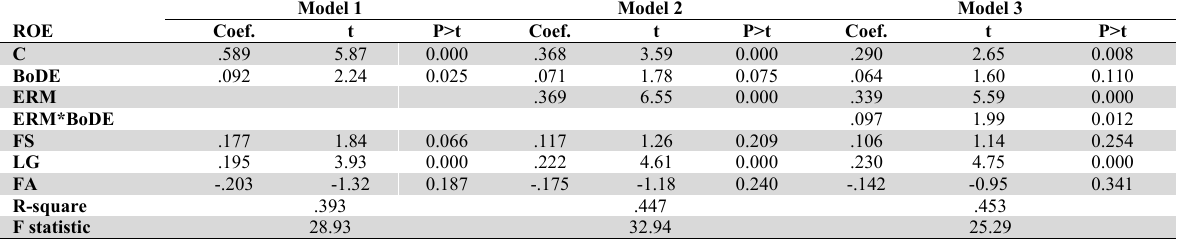
Table 8 demonstrates the results of the tested moderating effect of ERM between BoDE with ROA. The outcomes the R- square has changed in model 1 from .414 to .507 in model 3 indicating that there is an increase in the explanatory power of the model in explaining the variation in return on assets. In Model 1, the effect of BoDE on ROA is significant at a level of 0.05. Similarly, the effect of the control variables is significant. The moderating variable ERM in model 2 has a significant positive relationship with ROA. The third model (Model3) included the interaction effects and it showed that the relationship of BoDE*ERM on ROA is positive and significant. This indicates that there is a positive interaction effect between BoD effectiveness and enterprise risk management supporting the hypothesis of a positive relationship. The positive interaction indicates that the increase in ERM practices and implementation in the context of industrial and services companies in Jordan lead to an increase in the positive relationship between BoD effectiveness and ROA. Therefore, H1a, which predicted that ERM positively impacts the association between BoDE and ROA, was Accepted . The result of the moderating effect of ERM between BoDE and ROE Model 1 Model 2 Coef.